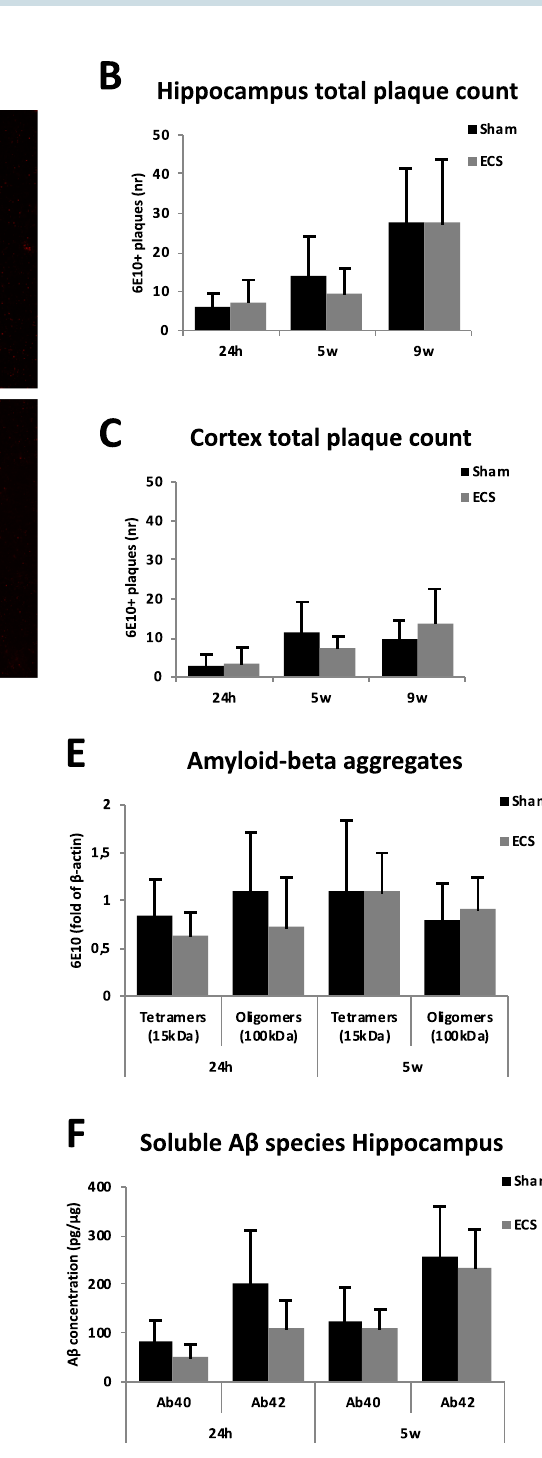
Figure 1. The effects of ECS on Aβ peptides, aggregates and plaques. ( A ) Representative confocal microscopy images (20 ×) of 6E10 staining in dentate gyrus. Scale bars represent 100 μm. Quantification of total plaque count from immunohistochemical staining in ( B ) hippocampus and ( C ) cortex. Images were analyzed with the free version ImageJ 1.52 (https ://image j.nih.gov/ij/). ( D ) Image of Western blot visualising tetramers and oligomers of Aβ aggregates. ( E ) Western Blot levels of Aβ aggregates in ECS and sham groups sacrificed 24 h and 5w after the last ECS session. The dotted lines on the gel indicate where western blot gel images have been cropped to align groups in a representative order. Original gels are available in Supplementary Figs. S3 and S4. ( F ) Concentration of soluble beta amyloid peptides (Aβ40 and 42) in ECS and sham groups sacrificed 24 h and 5 w after last ECS session. Bars represents mean values with error bars displaying SD. Analyses were done by unpaired two-tailed T-test ( p ≤ 0.05*). For the 24 h groups, n = 4–8 for sham and n = 5–7 for ECS. For the 5 weeks groups, n = 8–10 for sham and n = 9 for ECS. For the 9 weeks groups, n = 5 for sham and n = 6 for